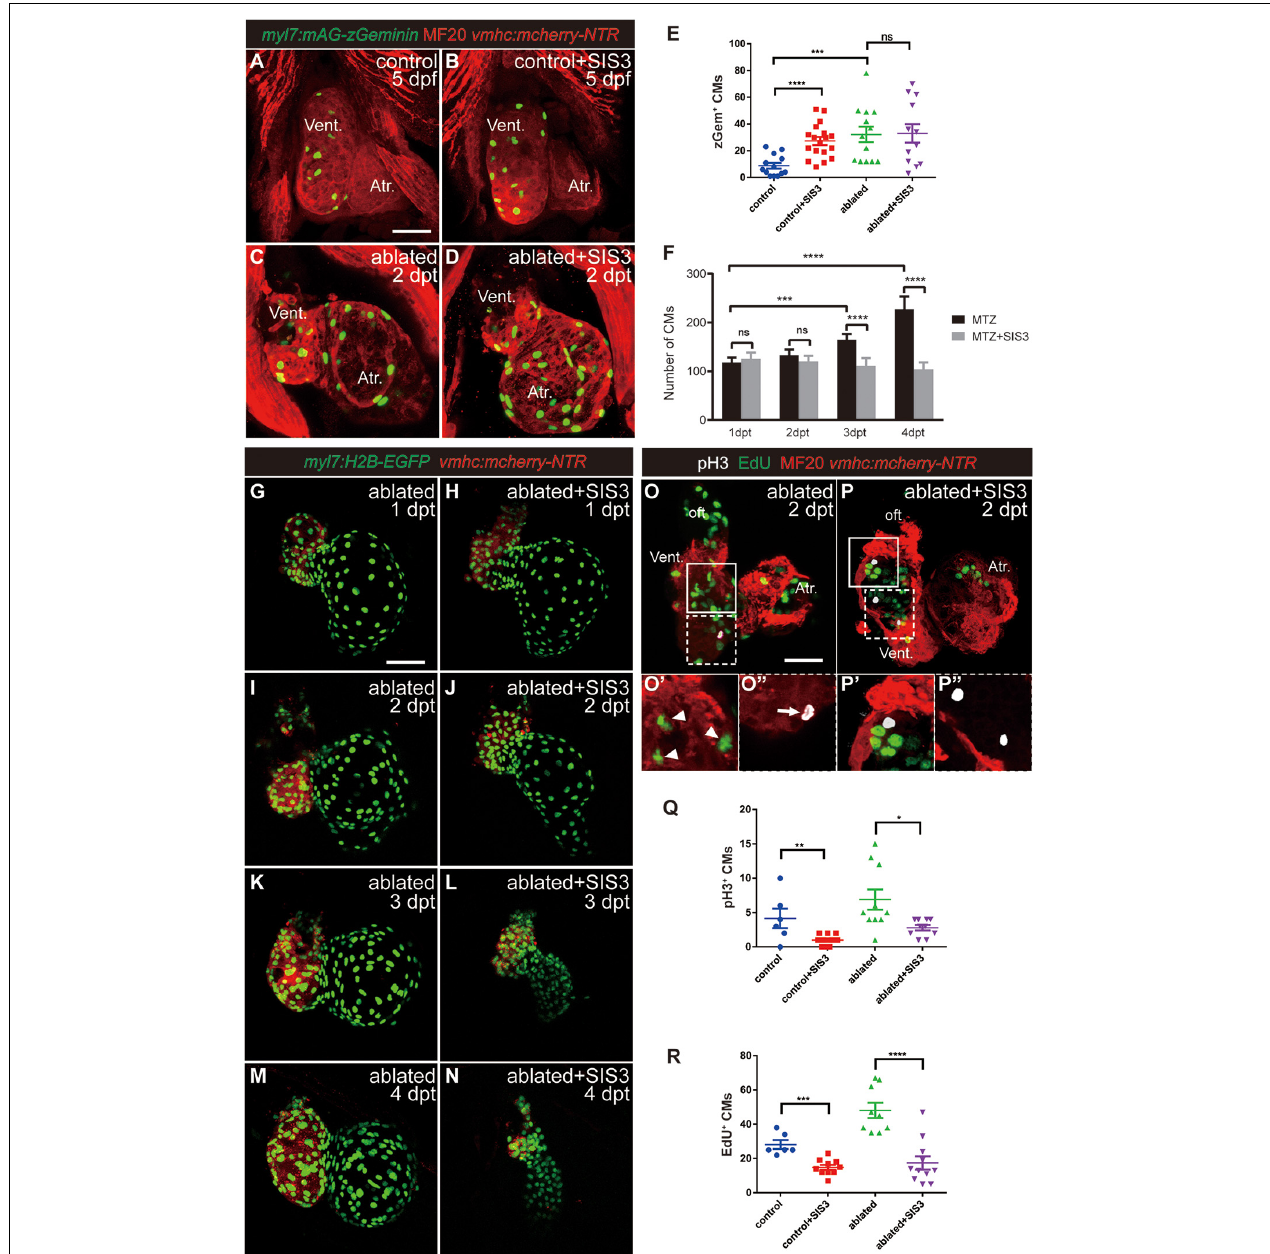
FIGURE 4 | Smad3 inhibition affects CM proliferation during regeneration. (A–D) Representative fluorescence images of Tg(vmhc:mCherry-NTR; myl7:mAG-zGeminin) larvae with immunostaining of MF20 (anti-MHC) at 5 dpf/2 dpt showing zGeminin-positive CMs in the control or ablated hearts without or with SIS3 treatment. (E) Quantification of zGeminin-positive CM number in the control or ablated hearts without or with SIS3 treatment at 5 dpf/2 dpt. N = 13, 18, 13, and 12, respectively. Mean ± s.e.m., Student’s t -test, two-tailed; ns, non-significant; *** P < 0.001, **** P < 0.0001. (F) Quantification of CM nucleus number in the ablated hearts without or with SIS3 treatment at various time points. N = 8 for each group. Mean ± s.e.m., Student’s t -test, two-tailed; ns, non-significant; *** P < 0.001, **** P < 0.0001. (G–N) Representative fluorescence images of Tg(vmhc:mCherry-NTR; myl7:H2B-EGFP) ablated hearts without or with SIS3 treatment at various time points showing the change of CM nucleus number. (O–P (cid:48)(cid:48) ) Representative fluorescent images of Tg(vmhc:mCherry-NTR) hearts with immunostaining of phospho-histone H3 (white), MF20 (red), and EdU (green) in the ablated hearts without or with SIS3 treatment at 5 dpf/2 dpt. (O,P) Maximal projections of z-stack images, overlay of three channels. (O (cid:48) ,P (cid:48) ) Optical sections of enlargement of box area in panels (O,P) , overlay of red and green channels. (O (cid:48)(cid:48) ,P (cid:48)(cid:48) ) Optical sections of enlargement of dashed box area in panels (O,P) , overlay of red and white channels. Arrowheads point to EdU + CMs; arrow points to pH3 + CMs. (Q) Quantification of pH3-positive CM number in the control or ablated hearts without or with SIS3 treatment at 5 dpf/2 dpt. N = 6, 11, 10, and 10, respectively. Mean ± s.e.m., Student’s t -test, two-tailed, * P < 0.05, ** P < 0.01. (R) Quantification of EdU-positive CM number in the control or ablated hearts without or with SIS3 treatment at 5 dpf/2 dpt. N = 6, 10, 9, and 11, respectively. Mean ± s.e.m., Student’s t -test, two-tailed, *** P < 0.001, **** P < 0.0001. Scale bars, 50 µ m. dpf, days post-fertilization, dpt, days post-treatment; atr., atrium; oft., out flow tract; vent., ventricle; CM, cardiomyocyte.